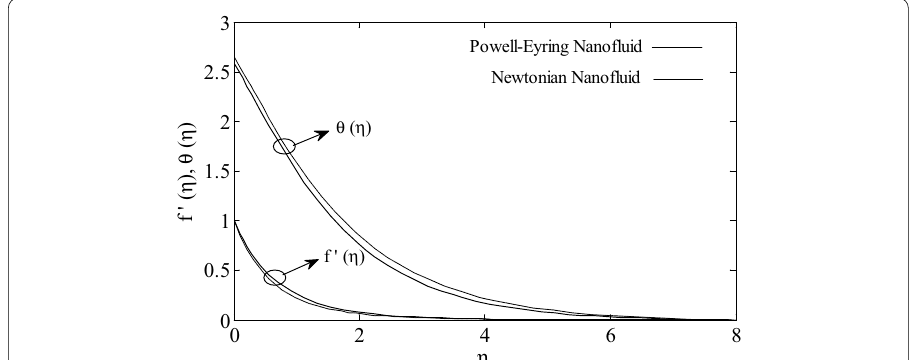
Fig. 10 Impact of Powell–Eyring nanofluid and Newtonian nanofluid on ( f ′ (η) , θ(η)